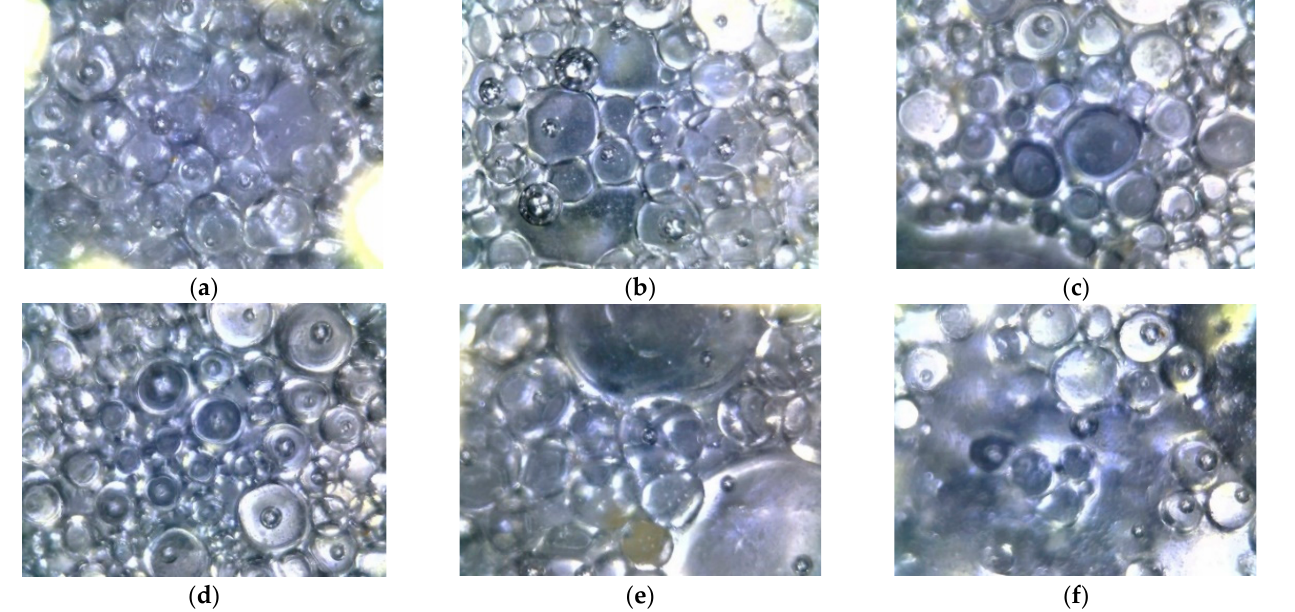
Figure 13. Microscopy images of oil droplet size at the outlet of the vertical separator under six working states. ( a ) Blank tube; ( b ) semicircular baffle; ( c ) spiral track; ( d ) four-hole plate; ( e ) seven- hole plate; ( f ) all five risers are open.